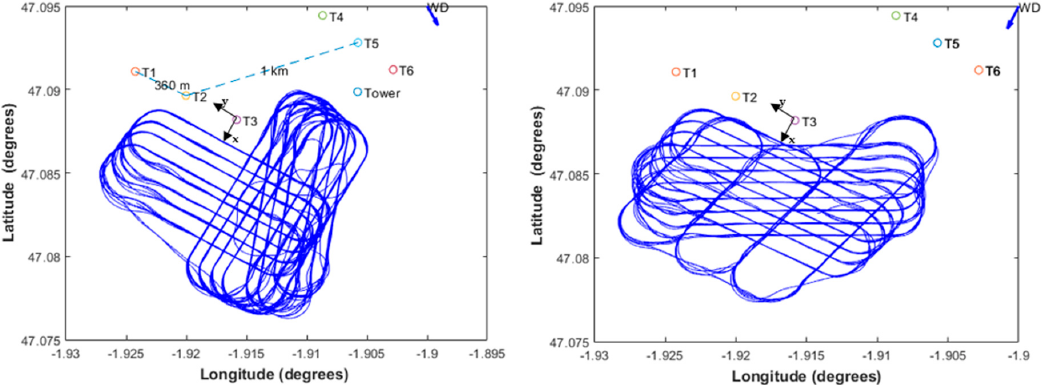
Figure 5. The flight patterns on 28 April ( left side ) and on 30 April ( right side ). The positions of the six wind turbines and their designation names are pointed out by T1, T2, T3, T4, T5, and T6 in the figure. The localization of the 79 m instrumented mast is indicated by “Tower” in the figure. The blue arrows indicate the average wind direction (WD) for each flight. The “x” and “y” arrows mark the frame for the plots in the forthcoming figures.